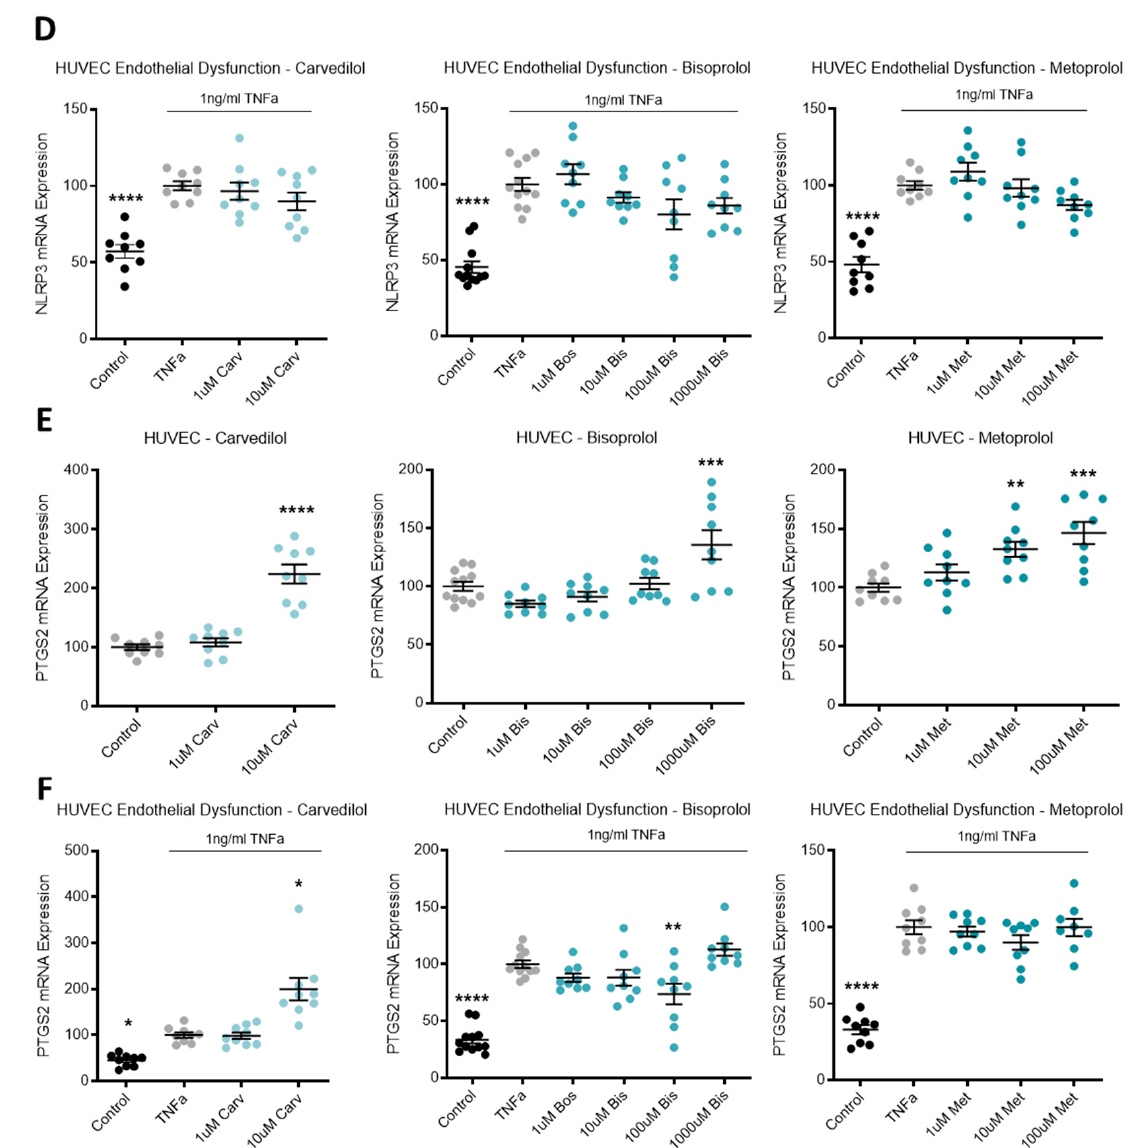
Figure 4. Inflammatory markers are altered following beta-blocker treatment. Expression of IL-1b mRNA in HUVECs ( A ) was not affected by treatment with beta-blockers carvedilol (Carv), bisoprolol (Bis), or metoprolol (Met). When TNF α is added to HUVECs to induce endothelial dysfunction, IL-1b expression is significantly increased from control levels ( B ) and decreases with doses of Bis and Met, but not Carv. TNF α induced endothelial dysfunction also significantly increases mRNA levels of IL-6 ( C ) and NLRP3 ( D ). Beta-blocker treatment with top dose Carv, Bis, and Met significantly decreases induced IL-6 expression ( C ). NLRP3 mRNA expression was not affected by beta-blockers treatment ( D ). Expression of PTGS2 mRNA in HUVECs ( E ) was significantly increased following top dose beta-blocker treatment with Carv, Bis, and Met. PTGS2 expression is significantly induced with TNF α (endothelial dysfunction) ( F ), which is further increased with top dose Carv, decreased with 100 uM Bis, and unaffected by Met. Data are mean ± SEM, expressed as a percentage of control (HUVEC) or TNF α control (endothelial dysfunction), n = 3–4, * p < 0.05, ** p < 0.01, *** p < 0.001, **** p < 0.0001.